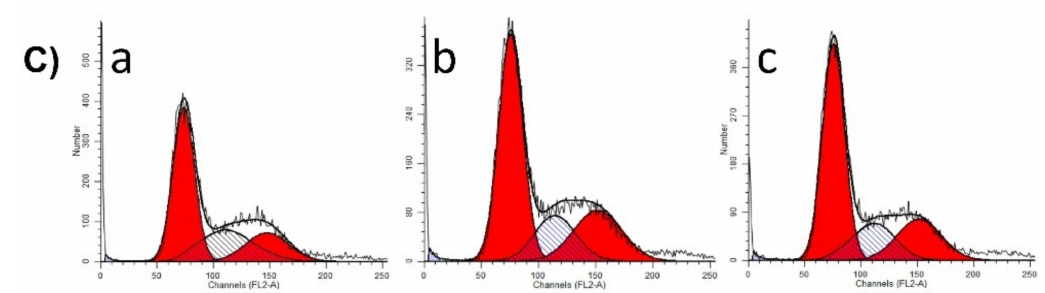
Figure 4. R epresentative histograms that describe the effect of ( A ) MC, ( B ) C, ( C ) P on cell cycle phases of A375 melanoma cell line with the following assignments: ( a ) Control, ( b ) 30 µ g/mL, ( c ) 60 µ g/mL.